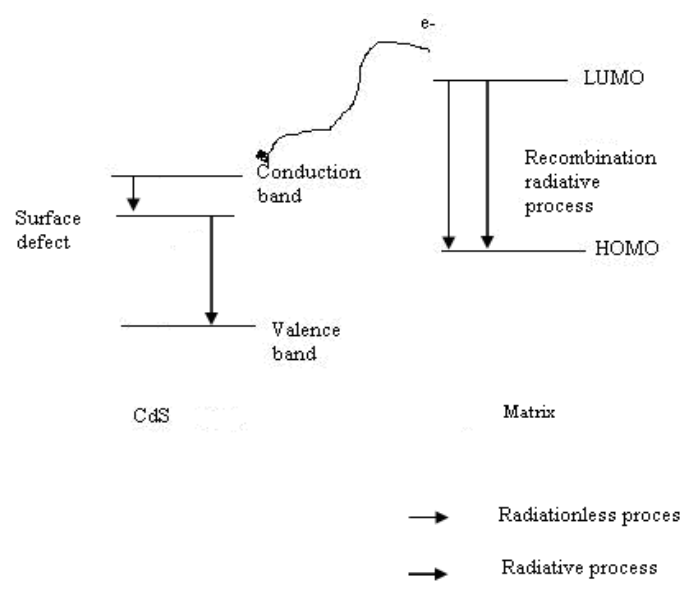
Figure 14. Temperature dependence studies on PL in CdS: IIa nanocomposites at